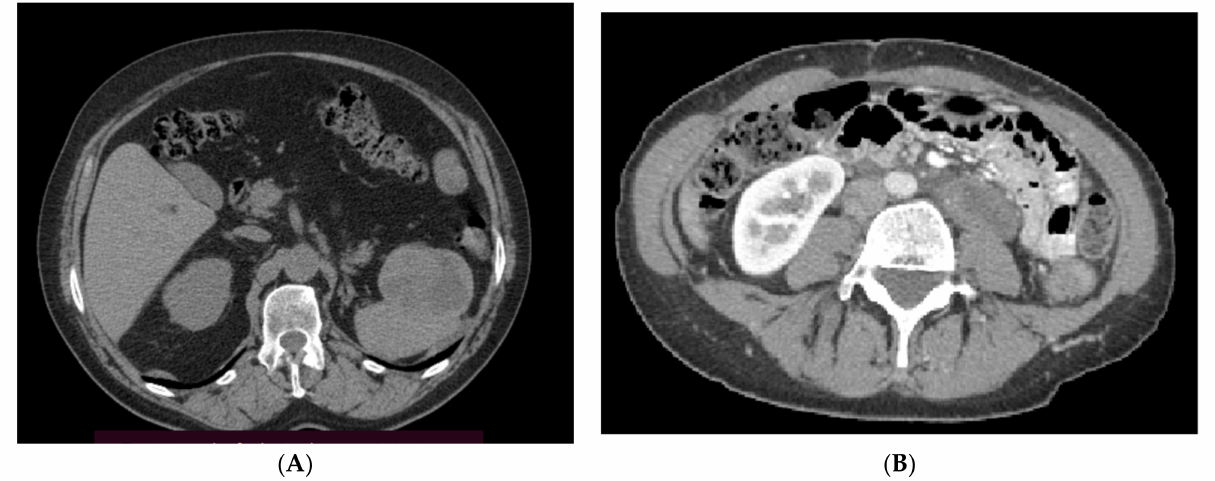
Figure 1. Patient with metastatic retroperitoneal PEComa of the kidney ( A ) and PEComa NOS ( B ) with large pelvic and J. Clin. Med. 2021 , 10 , x FOR PEER REVIEW intraperitoneal tumors.